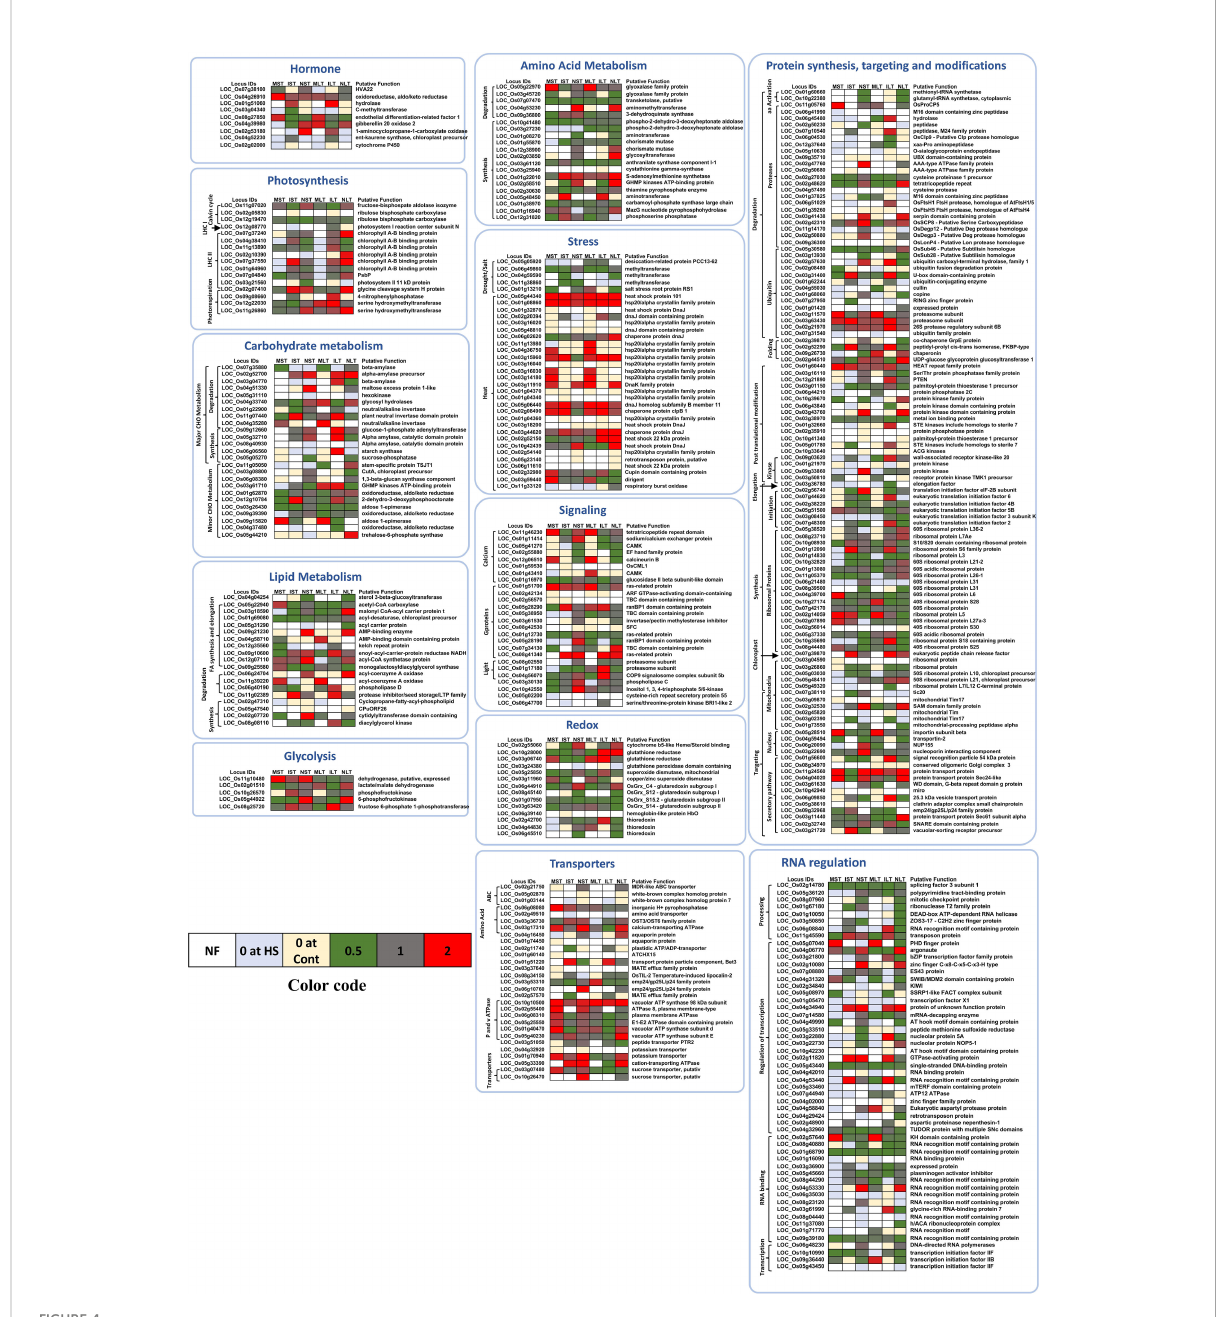
FIGURE 4 Heat maps depicting the relative abundance of proteins related to different pathways. The proteins signi fi cantly changed and differentially abundant in at least one genotype and at least in one condition are shown here. The color bar indicates the color codes used in making the heat map. White color- protein not found (NF); light blue- not found in HS; yellow- exclusively found in HS; green- downregulated (below 0.5 folds); grey- no change; red- upregulated (above 2 folds). ST, Short term heat stress; LT, Long-term heat stress; MC, Moroberekan control; MST, Moroberekan ST_HS; MLT, Moroberekan LT_HS; IC, IR64 control; IST, IR64 ST_HS; ILT, IR64 LT_HS; NC, N22 control; NST, N22 ST_HS; NLT, N22 LT_HS; UP, upregulated; DN,